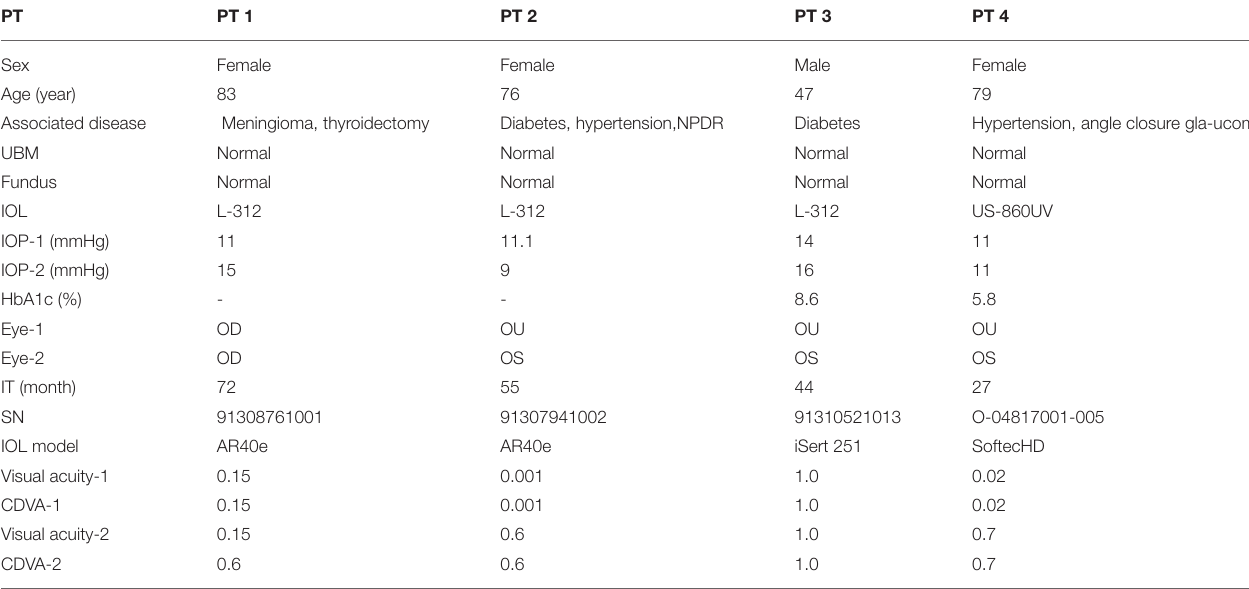
TABLE 1 | Characteristics of the 4 cases opacity